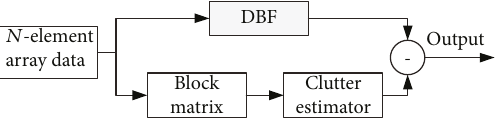
Figure 8: Framework of the